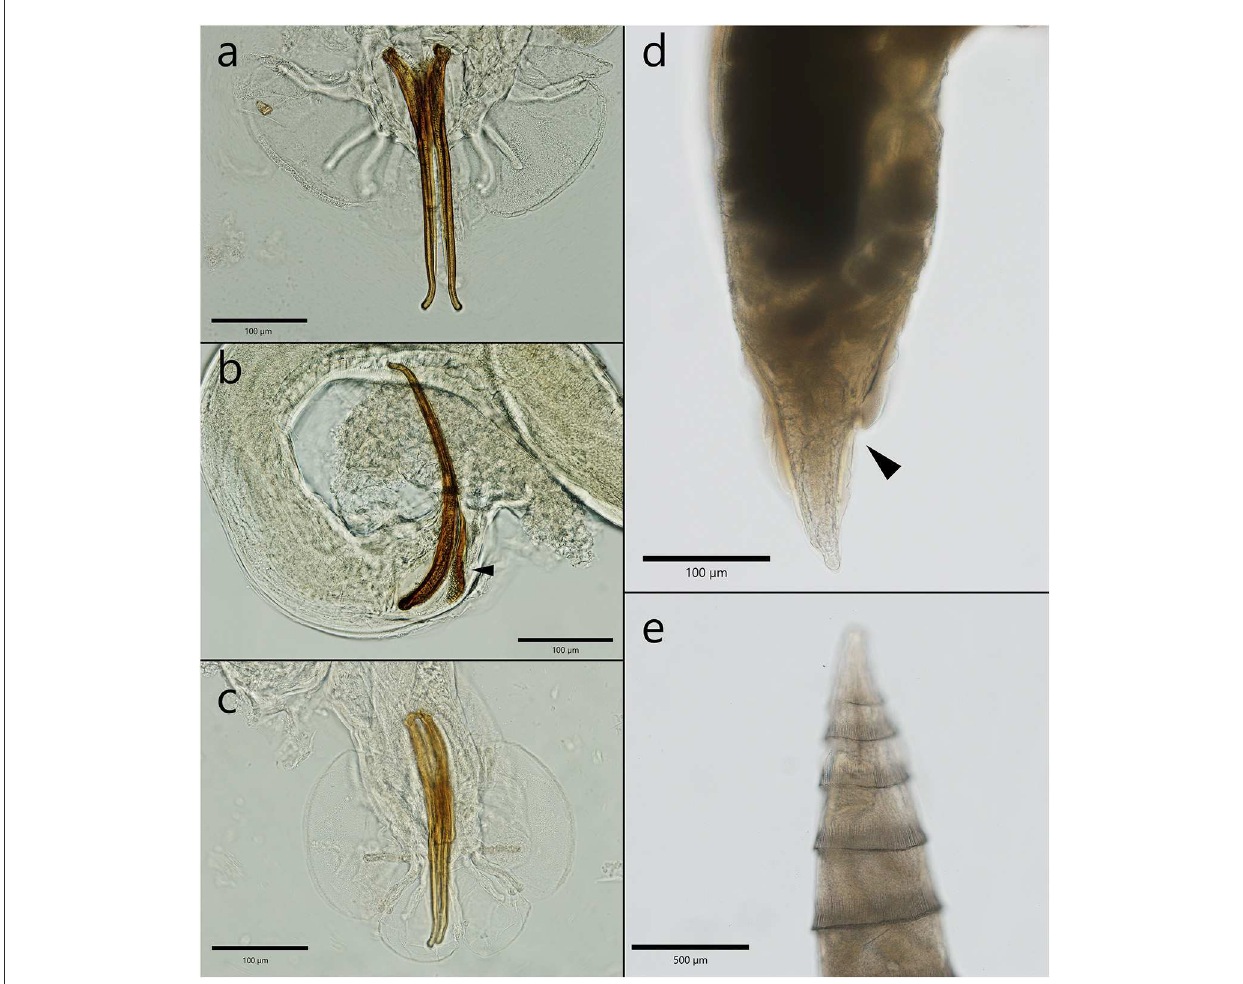
FIGURE3 The morphological characteristics of male and female C. petrowi . (a) Posterior extremity of a male with the two spicules—note the thin protrusion; (b) lateral view of a male caudal bursa—the characteristic shape of the gubernaculum (arrow head); (c) the posterior extremity of a male with the typical caudal bursa; (d) posterior extremity of a female nematode; (e) specific folds in the anterior extremity.